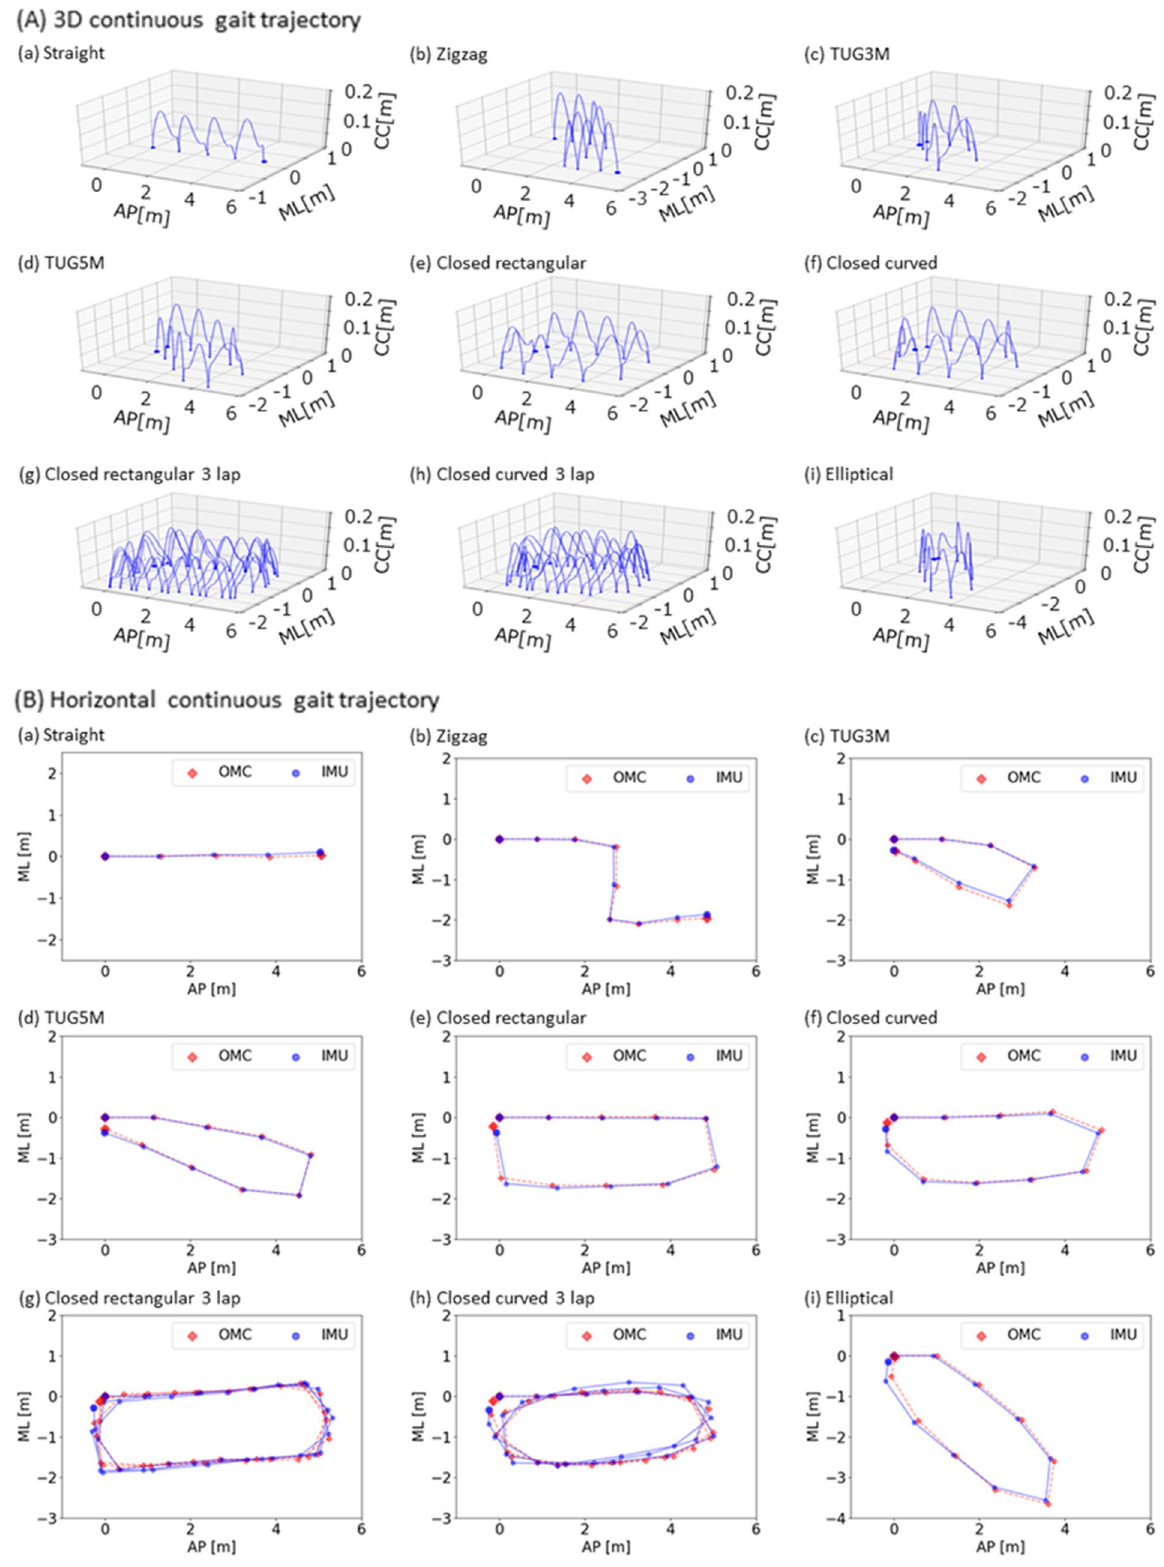
Figure 1. Examples of continuous gait trajectory estimated by the proposed method with single shank-worn IMU in the nine walking route conditions. ( A ) 3D continuous gait trajectory, ( B ) Horizontal continuous gait trajectory, ( a ) straight, ( b ) zigzag, ( c ) TUG3M, ( d ) TUG5M, ( e ) closed rectangular, ( f ) closed curved, ( g ) closed rectangular 3 lap, ( h ) closed curved 3 lap, and ( i ) elliptical. In the axes, CC means craniocaudal direction, AP means anterior–posterior direction, and ML means medio-lateral